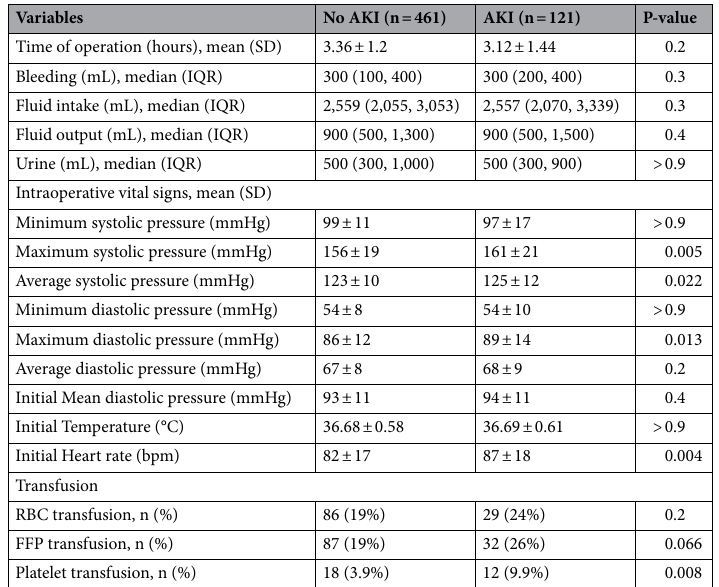
Table 2. Comparisons of intraoperative data between patients with and without AKI. AKI, acute kidney injury; RBC, red blood cells; FFP, fresh frozen plasma.